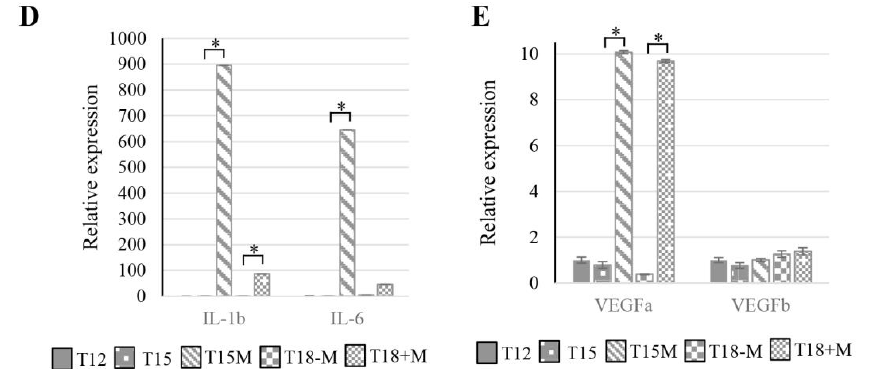
Figure 7. Cancer-cell-induced CD4 + T cell exhaustion may be reversed by removal of cancer cells. ( A ) PD-1 and PD-L1 protein